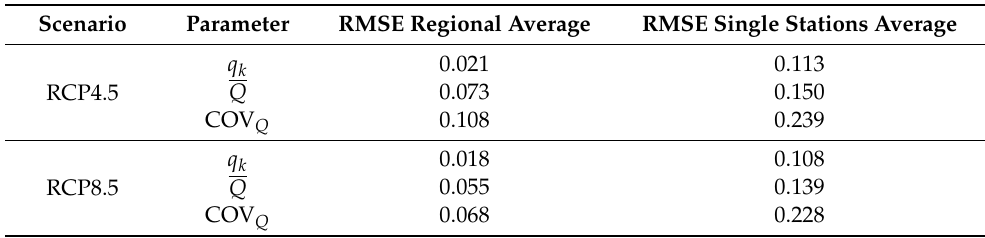
Table 4. RMSE statistics between FC obtained from the RCMs ensemble and the point measurements for the investigated weather